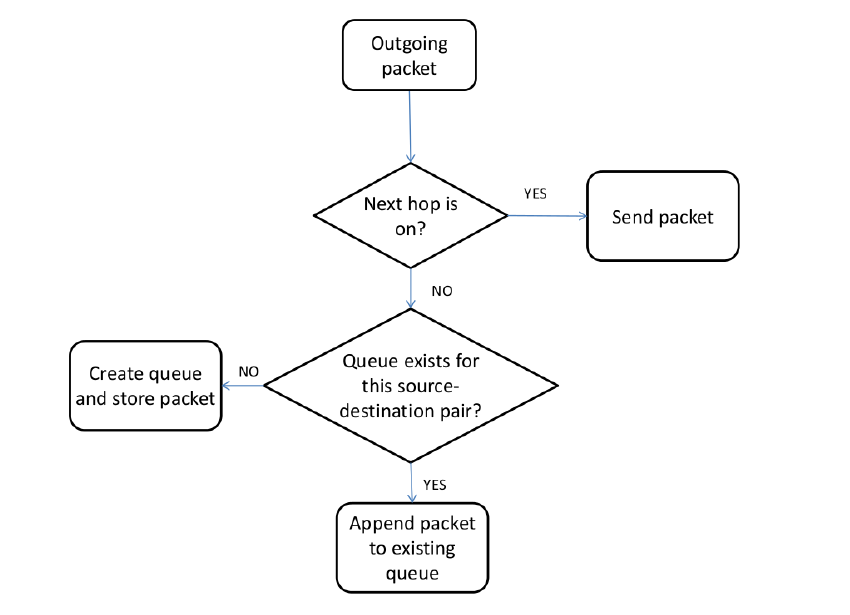
Figure 1. Description of the queuing